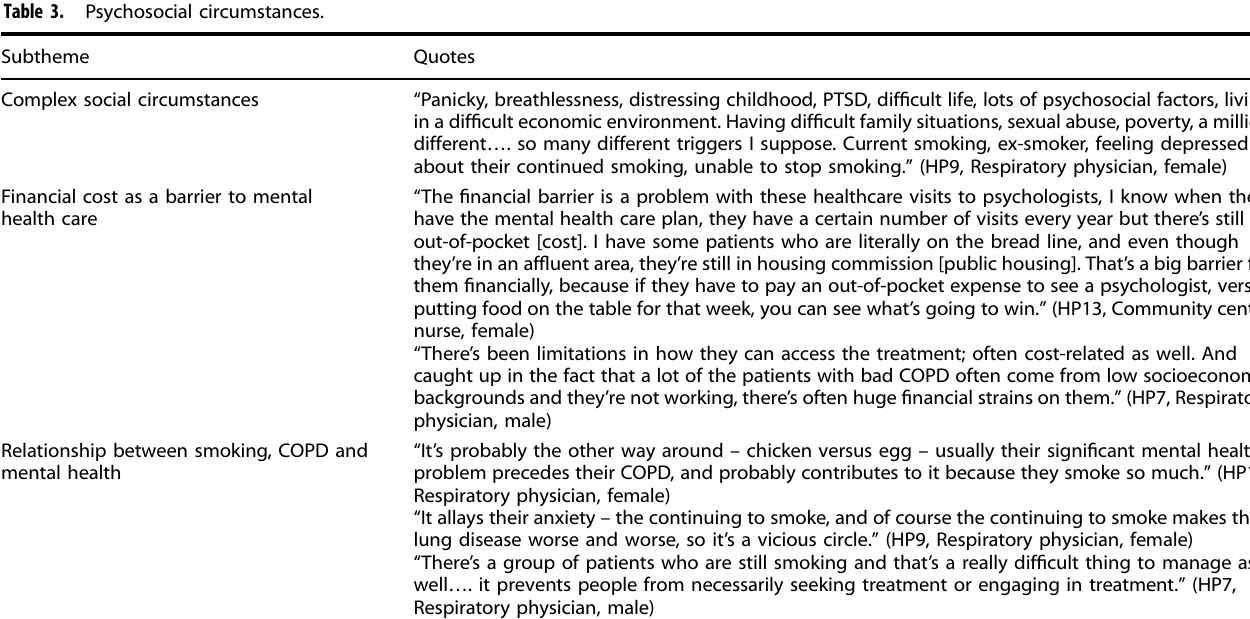
Table 3. Psychosocial